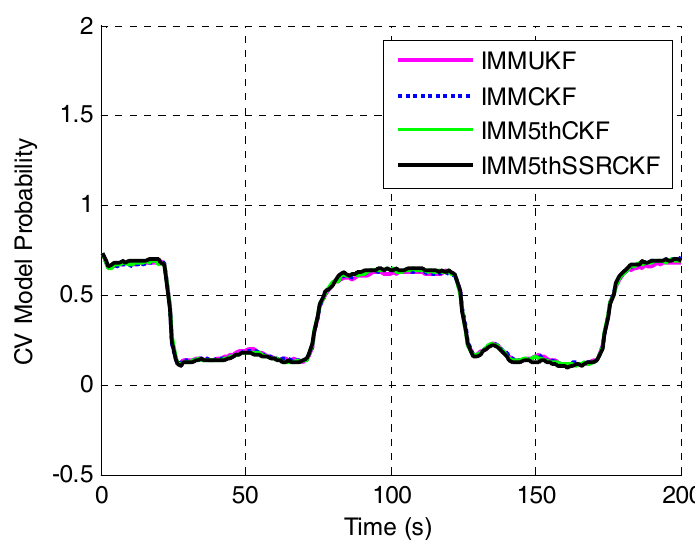
Figure 5. Constant velocity (CV) mode probability versus time step. Table 2. Number of points and computational time of different